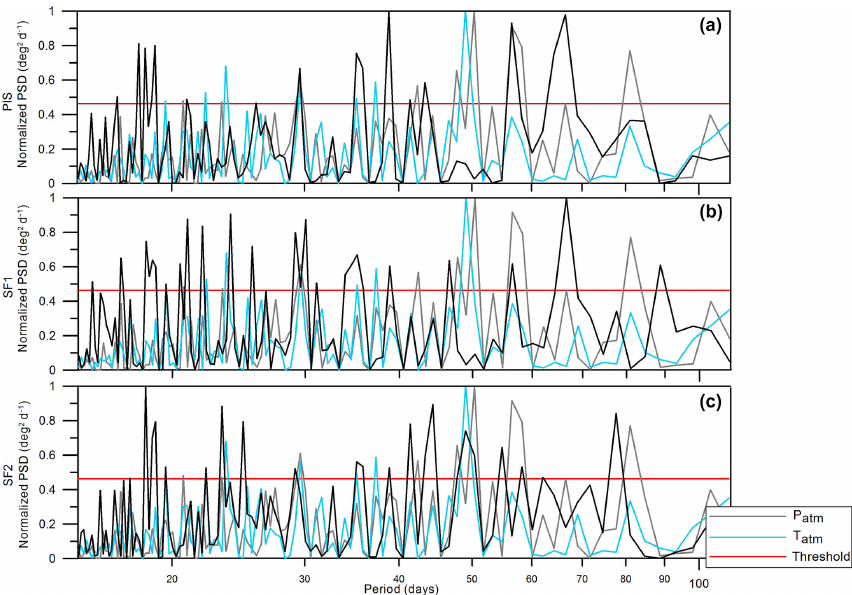
Figure 5. Power Spectral Densities as function of periods (days). The name of TIR stations is indicated on the vertical axes. Each TIR PSD (black lines) is superimposed to P atm (grey lines) and T atm (cyan lines). All the PSDs are normalized to their own maximum. Red horizontal lines indicate the thresholds for the high values of spectral amplitudes (see statistical analysis for details). The horizontal axes are in log